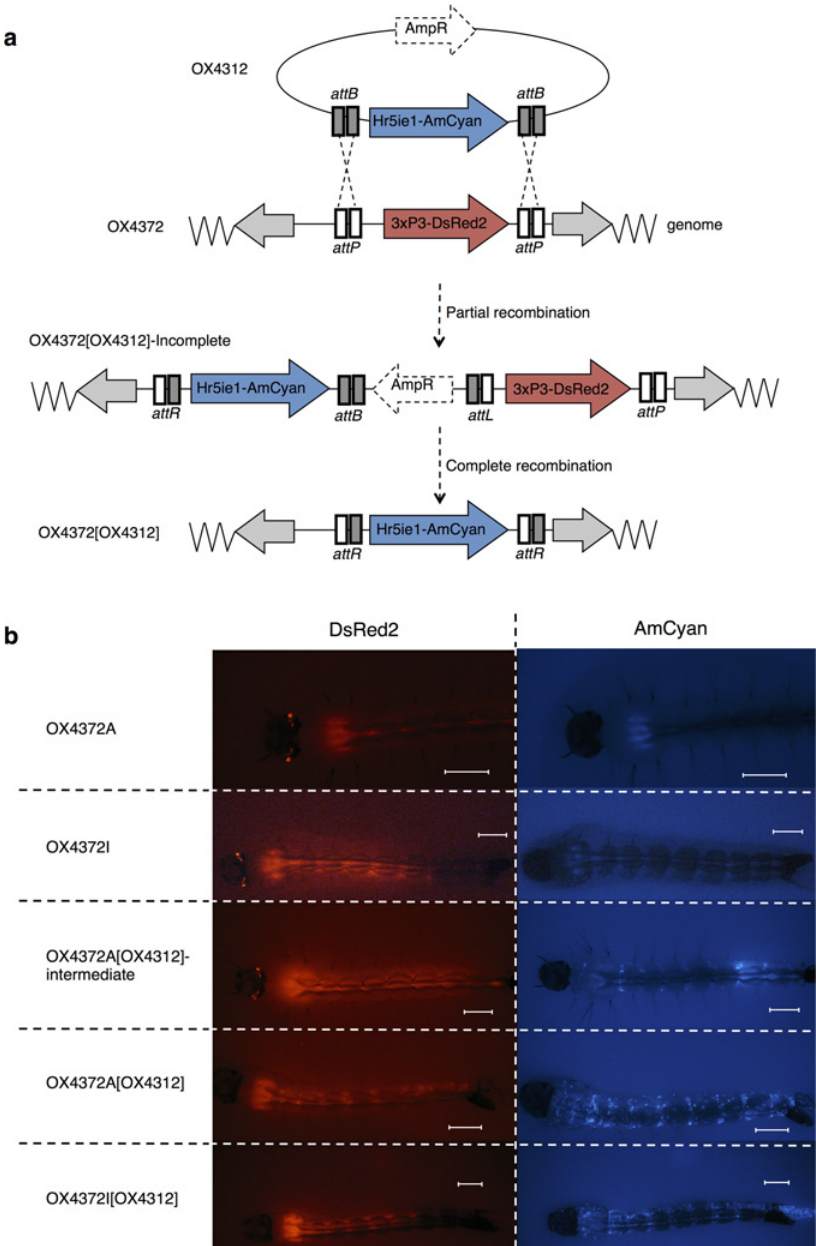
Fig 1. Φ C31-RMCE in Ae . aegypti . (a) Schematic diagram of recombination between constructs OX4372 and OX4312 in Φ C31-RMCE, and (b) fourth instar larval expression of fluorescent reported genes in Aedes aegypti OX4372 lines before and after Φ C31 mediated recombination with construct OX4312. OX4372A and OX4372I strains showed only 3xP3-DsRed2 (red eyes). Following recombination in the presence of the Φ C31-integrase, one set of attachment sites resulted in the expression of both 3xP3-DsRed2 (red eyes, shown with white arrows in top right panel) from the docking construct OX4372 and the Hr5ie1-AmCyan (blue bodies) from the donor construct OX4312 (OX4372A[OX4312]-incomplete). Recombination of both sets of Φ C31 attachment sites ( attB and attP ) resulted in complete RMCE, where only the AmCyan reporter (blue bodies) was observed in OX4372A[OX4312] and OX4372I[OX4312]; the 3xP3-DsRed2 marker for red eyes was excised in these insects (heads are to the left of images; diffuse red staining in larval thorax and abdomen is due to autofluorescence). Scale bars represent 1mm for each